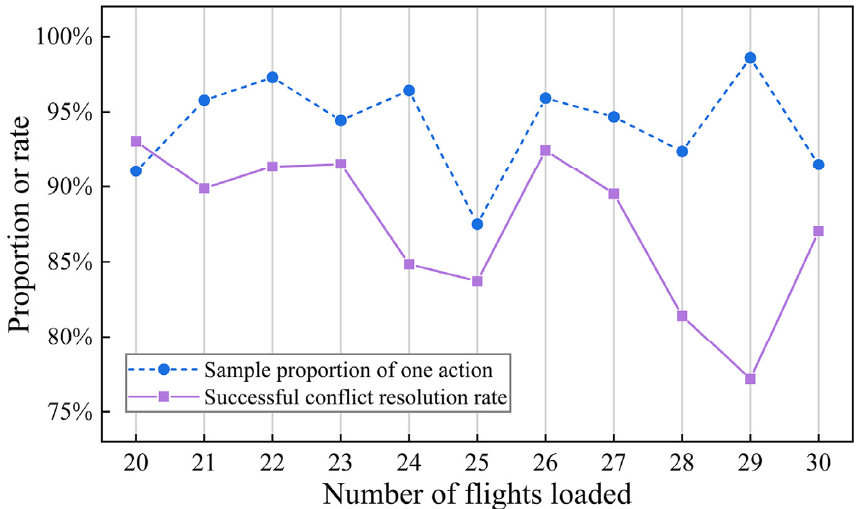
Figure 13. Performance of the TCS under different numbers of flights.